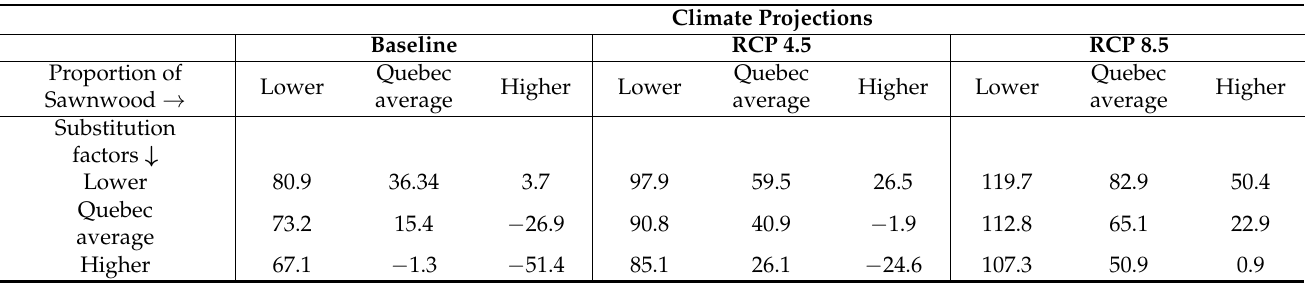
Table 3. Average mitigation potential of ecosystem-based forest management in Maskinong é compared to the conservation scenario in kt CO 2 eq. year − 1 for the 2020–2120 period under different radiative forcing scenarios and assumptions related to wood products and their substitution effects. The potential is based on the difference in the sum of fluxes from forest ecosystems, degradation of wood products and their substitution effect on markets relative to conservation. Positive values indicate emissions to the atmosphere while negative values indicate a sequestration (removal) or emission avoidance. Climate